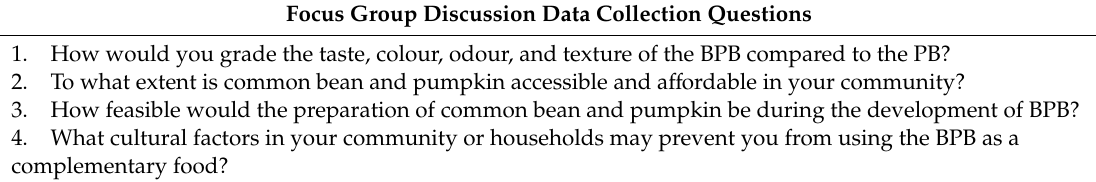
Table 3. Focus group discussion data collection